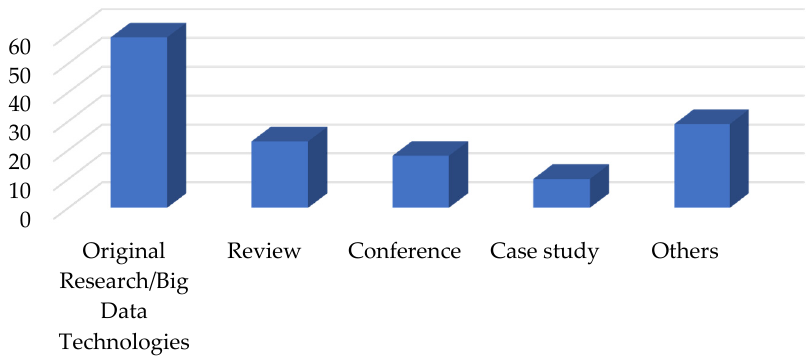
Figure 7. Article types reviewed in the study.